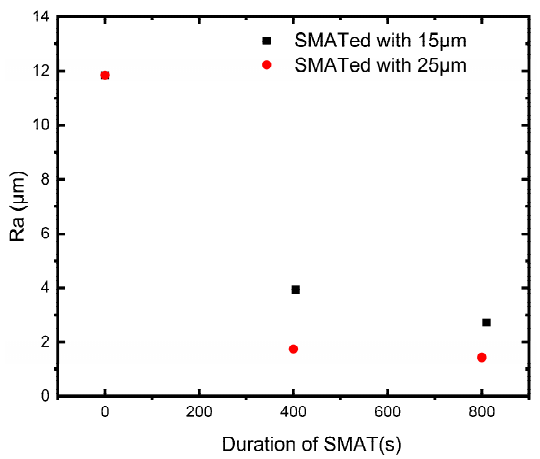
Figure 5. Surface roughness evolution as a function of SMAT duration and amplitude of vibration.